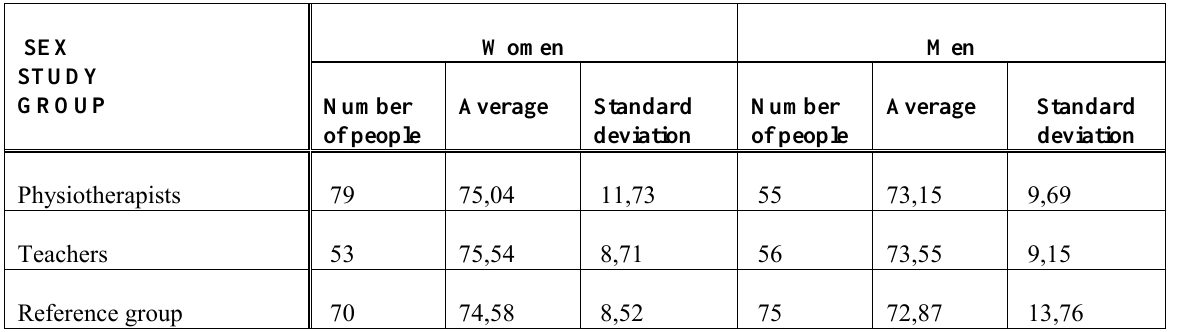
Emotional intelligence – the average of the results in the studied